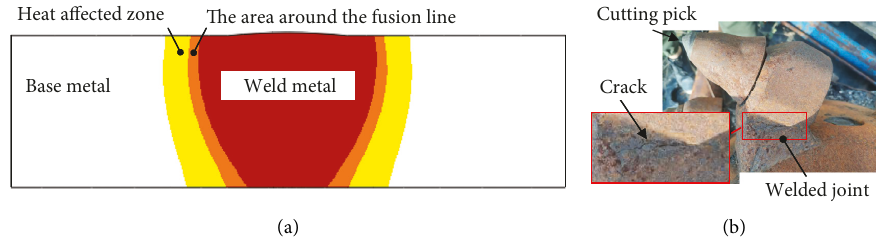
Figure 1: Composition and fracture of welded joint. (a) Composition of welded joint. (b) The fracture of the cutting pick base.